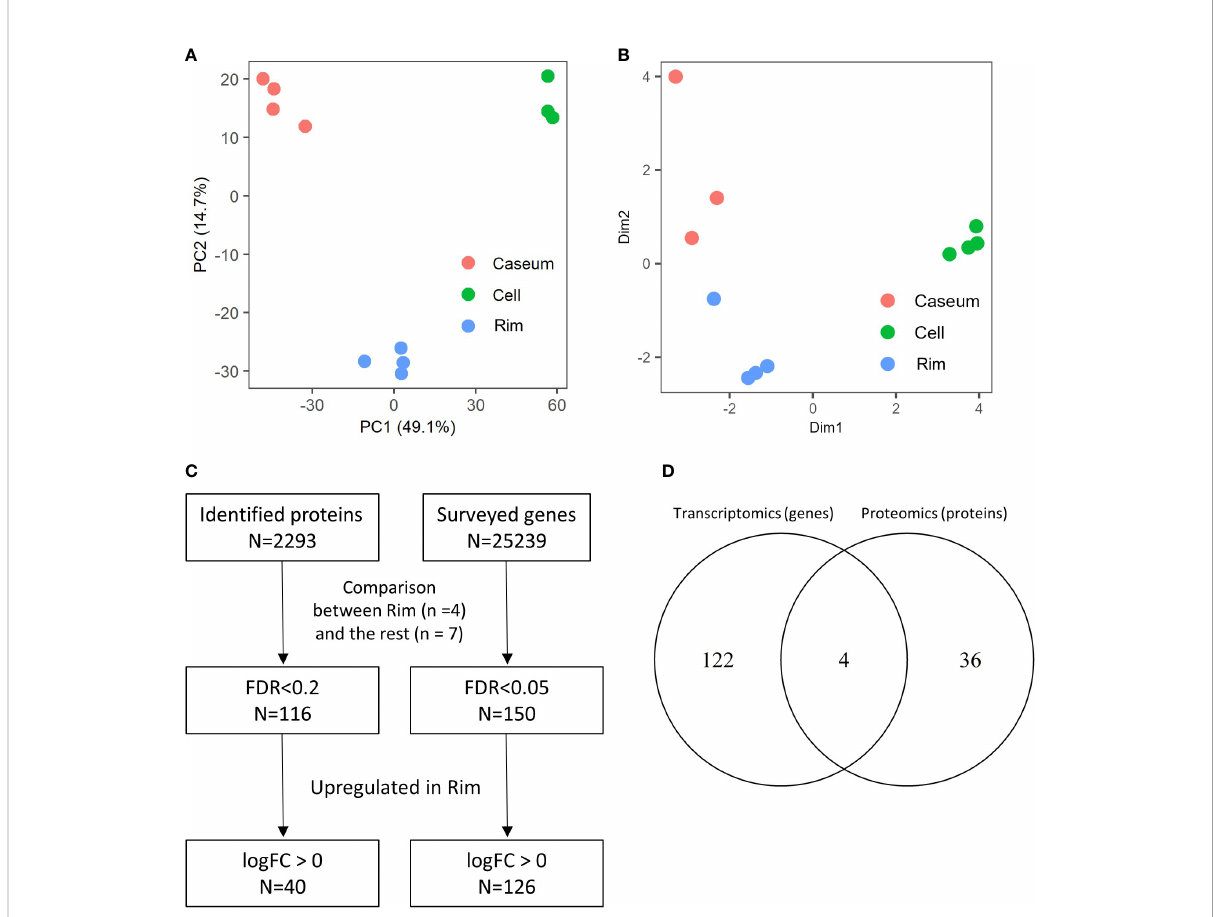
FIGURE 2 Spatial proteomic and transcriptomic pro fi ling to determine signatures enriched in Rim region within necrotic granulomas. Necrotic granulomas at 8 weeks p.i. were microdissected into three regions containing Caseum, Rim, and Cell. Proteins and RNA were extracted from granulomatous regions, followed by proteomic and transcriptomic analyses, respectively. (A) Principal component analysis (PCA) of granulomatous regions based on label- free quanti fi cation (LFQ) values of proteomic analysis. The fi rst two components, PC1 and PC2, accounted for 49.1% and 14.7% of the variability from all data, respectively, and are shown in the plot. (B) Multi-dimensional scaling (MDS) plot of distances between gene expression pro fi les of granulomatous regions based on differential gene expression results obtained from transcriptomic pro fi ling. (C) Flowchart describing the number of proteins and genes used to select signatures for Rim. The expression levels between four samples derived from Rim and seven samples derived from the other granulomatous regions were compared in proteomic and transcriptomic analyses. Welch ’ s t test with FDR correction, and generalized linear models and quasi-likelihood tests of edgeR were applied to identify the differentially expressed proteins and genes, respectively. (D) Venn diagram comparing the number of proteins or genes whose expression levels were upregulated in Rim region. The numbers of proteins or genes whose expression levels in Rim regions were signi fi cantly higher than those in the other two regions are